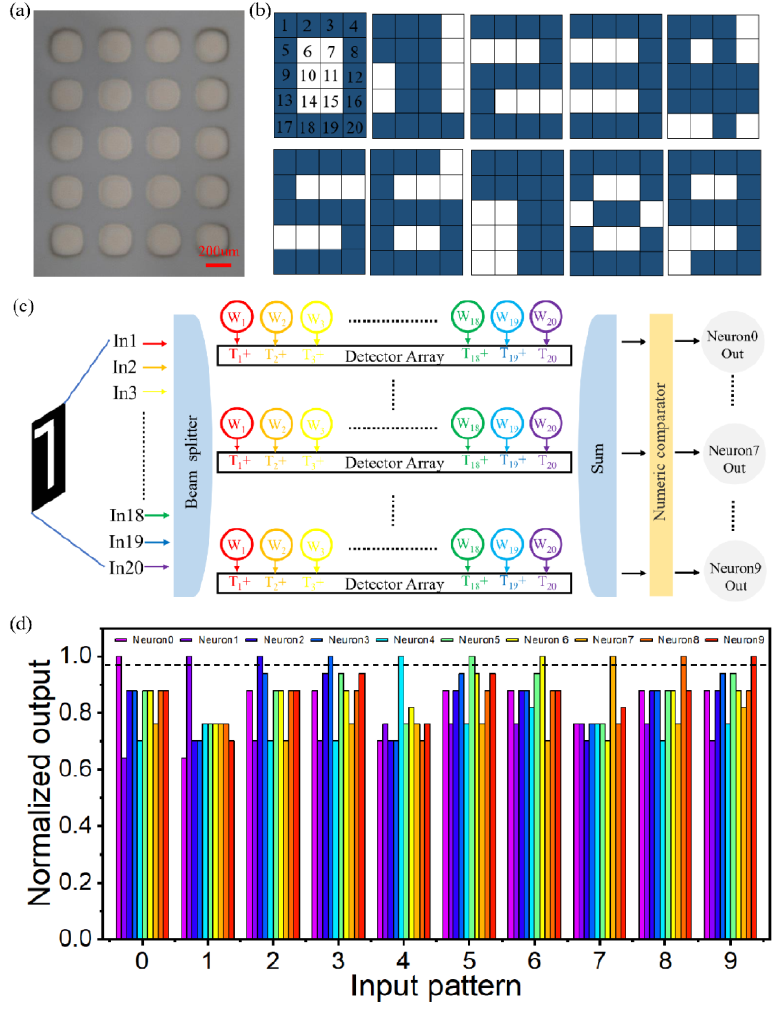
Figure 11. ( a ) Schematic diagram of a neuron composed of 20 synapses. ( b ) The corresponding synaptic weights of the numbers 0, 1, 2, 3, 4, 5, 6, 7, 8 and 9. ( c ) Schematic diagram of single-layer perceptron neural network for numerical recognition. ( d ) The variation of the normalized peak intensity of different input modes with different neurons.